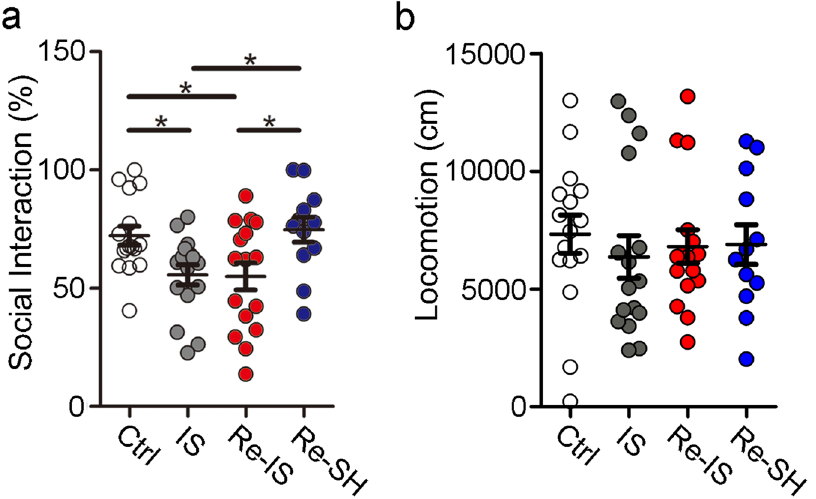
Figure 5. Social interaction depends on the mode of re-socialization. The ratio of time taken to approach a box with a mouse to that taken to approach a box without a mouse was measured. ( a ) Social interaction of IS and Re-IS mice was reduced compared to that of Ctrl, while Ctrl and Re-SH mice showed a comparable score for social interaction. Re-SH mice showed higher social interaction than IS and Re-IS mice. ( b ) There were no differences in the distance of locomotion during social interaction test. Ctrl; n = 16, IS; n = 16, Re-IS; n = 16, Re-SH; n = 12, * p < 0.05. Error bars =